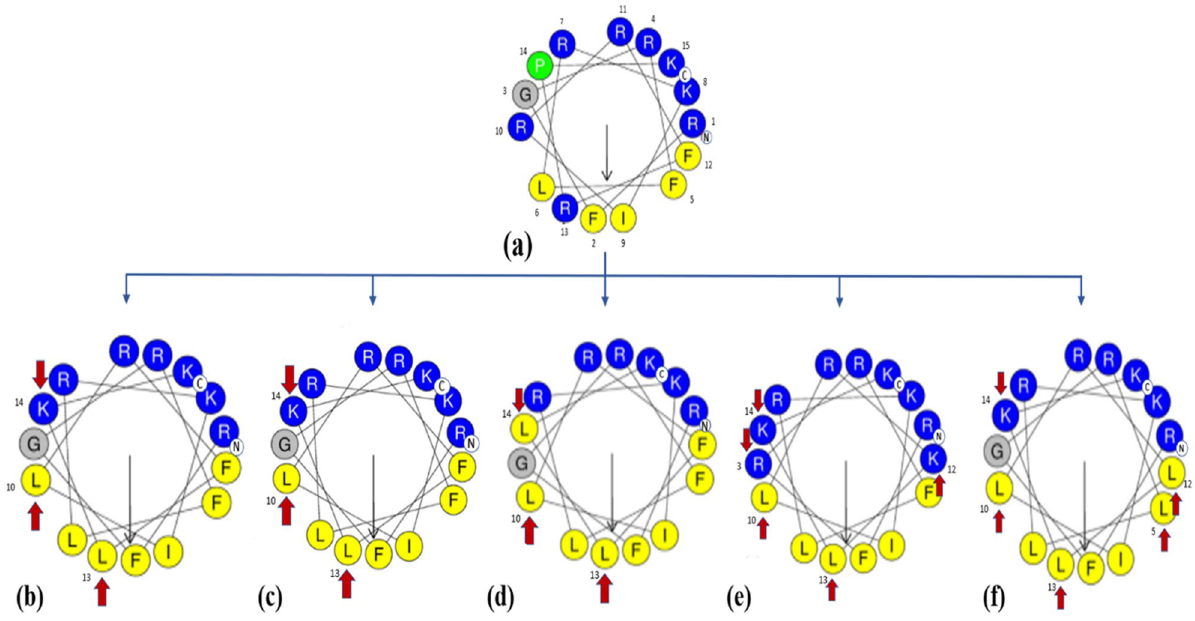
Figure 1. Helical wheel projections of N-15 CATH-2 ( a ), DP1 ( b ), DP2 ( c ), DP3 ( d ) DP4 ( e ) and DP5 ( f ). Residues are color-coded with non-polar hydrophobic residues in yellow, polar basic residues in dark blue, glycine in grey, and proline in green circles. The black arrow in the helical wheel corresponds to the hydrophobic moment and the red arrow indicates the residues substituted in N-15